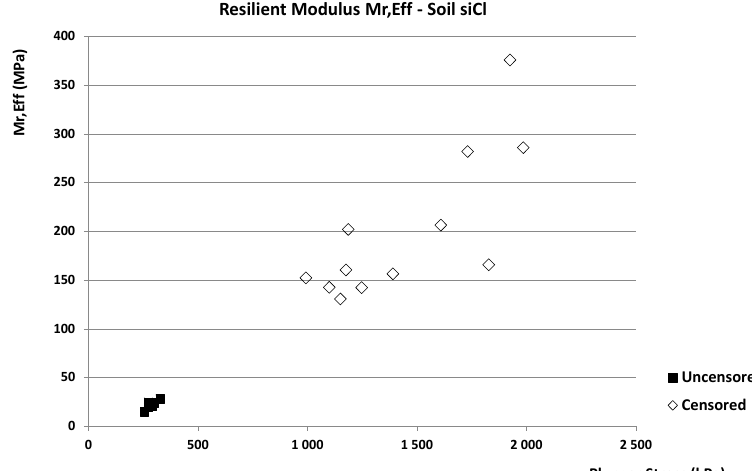
,eff for soil Cl.